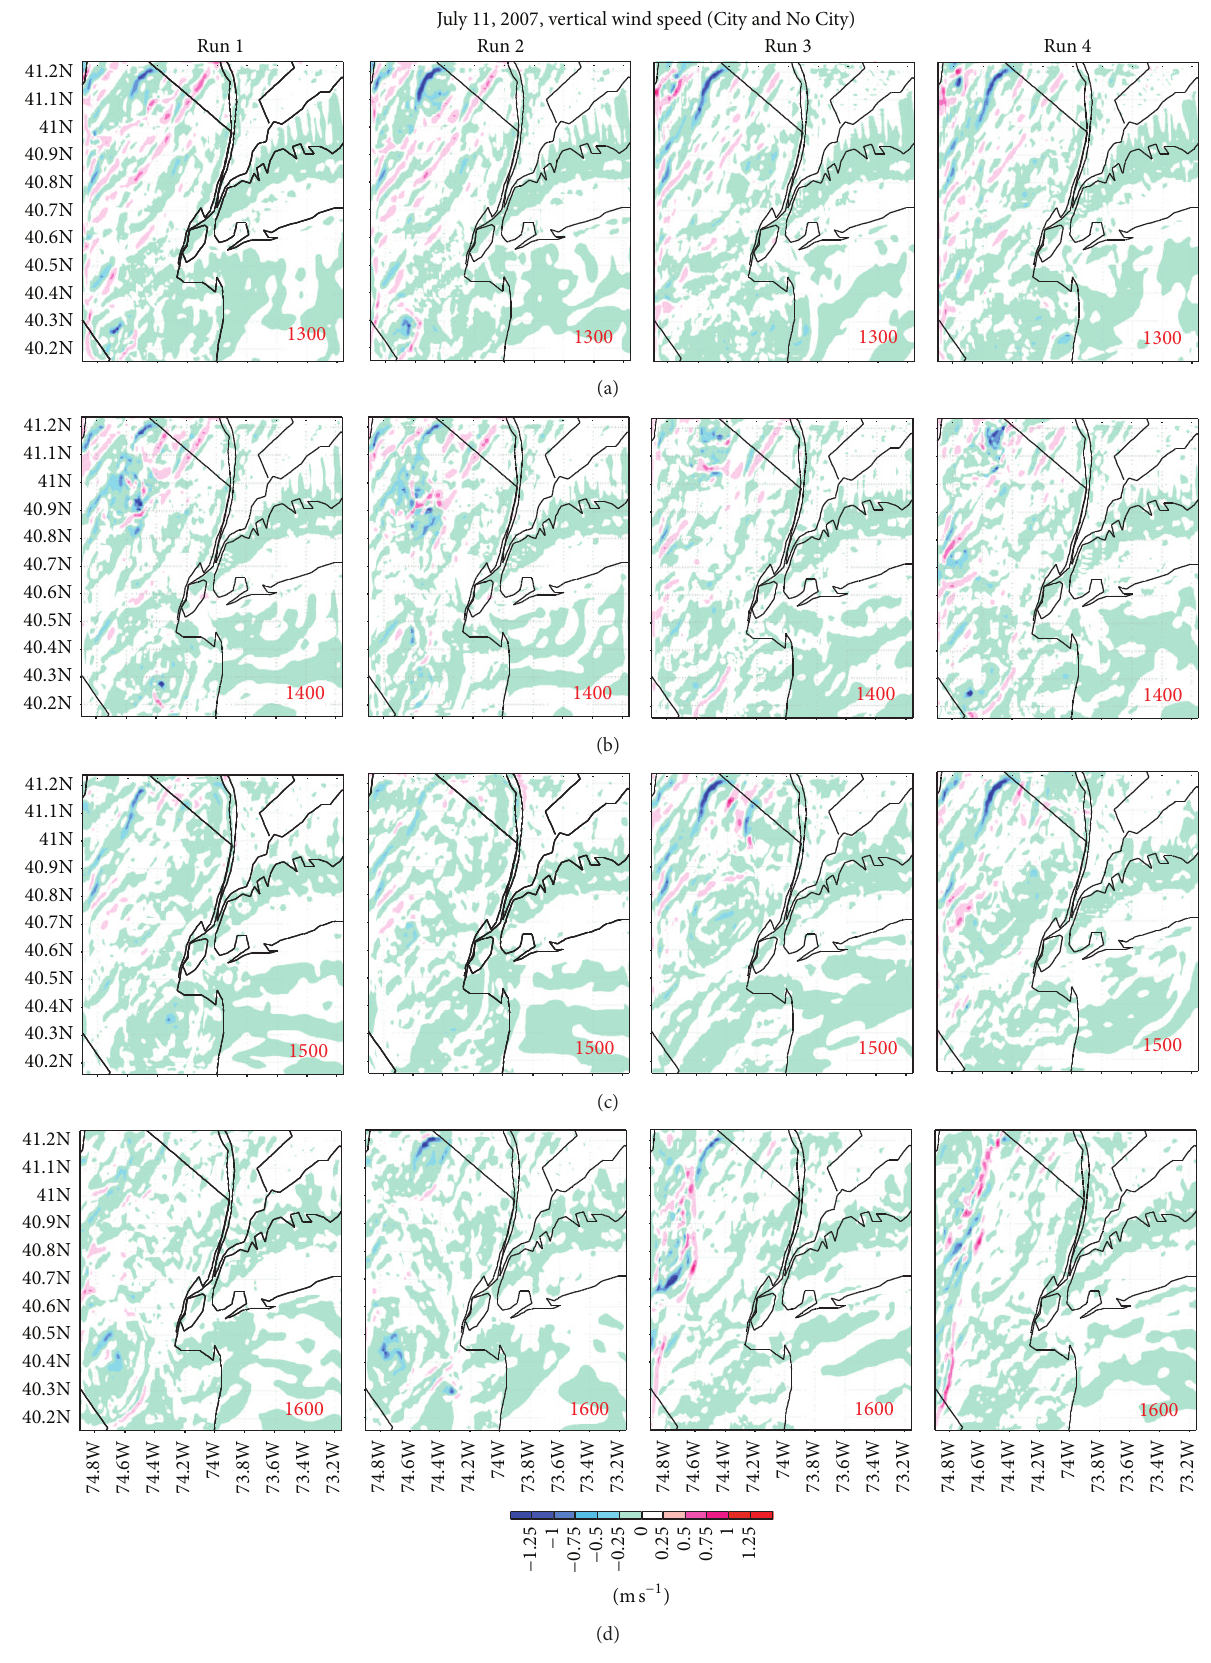
Figure 15: Vertical wind speed for Run 1, Run 2, Run 3, and Run 4. All times in